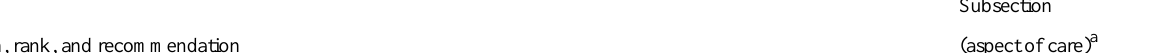
Table 1. Final set of the patients’ top-5 and top-3 recommendations (n = 23) for the 5 sections, ranked by importance to the quality of fertility care as formulated on the wiki